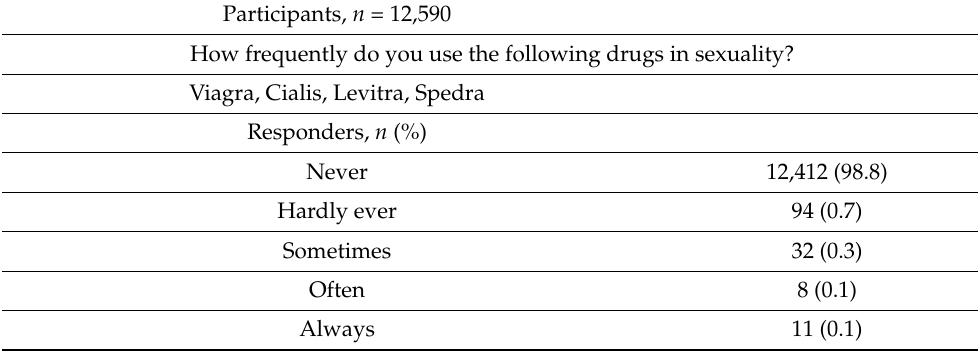
Table 5. Use of Substances among the general